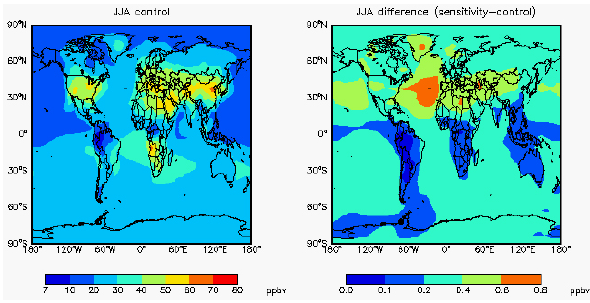
Fig. 3a. Changes in surface O 3 concentration due to stratospheric ozone recovery in December–February.